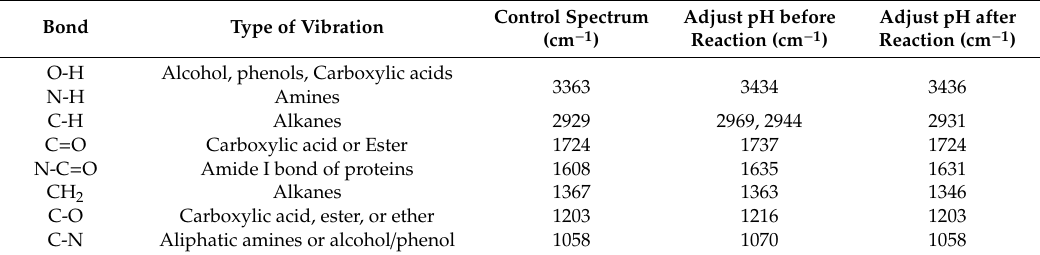
Figure 5. ( a – d ) Illustrates the transmission electron microscopy (TEM) images of nanoparticles synthesized using the C. sinensis peel extract at di ff erent pHs which are adjusted after the reaction. Table 2. Summary of the peak wavelength ( λ max ), Intensity, size of AuNPs obtained from C. sinensis peel at di ff erent experiment conditions.